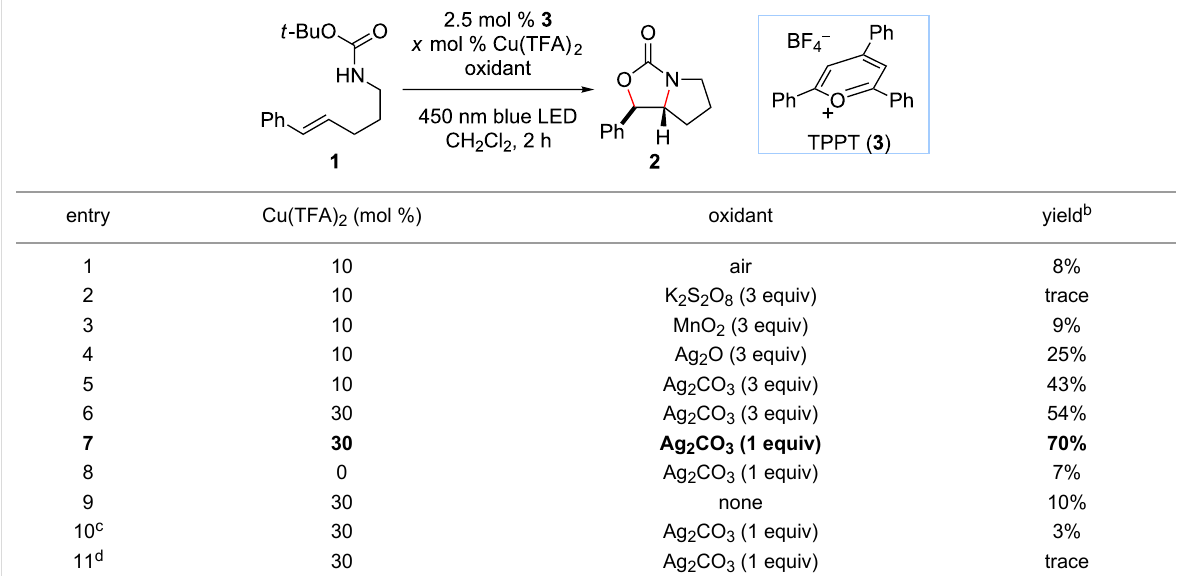
Table 1: Optimization of dual-catalytic reaction conditions a